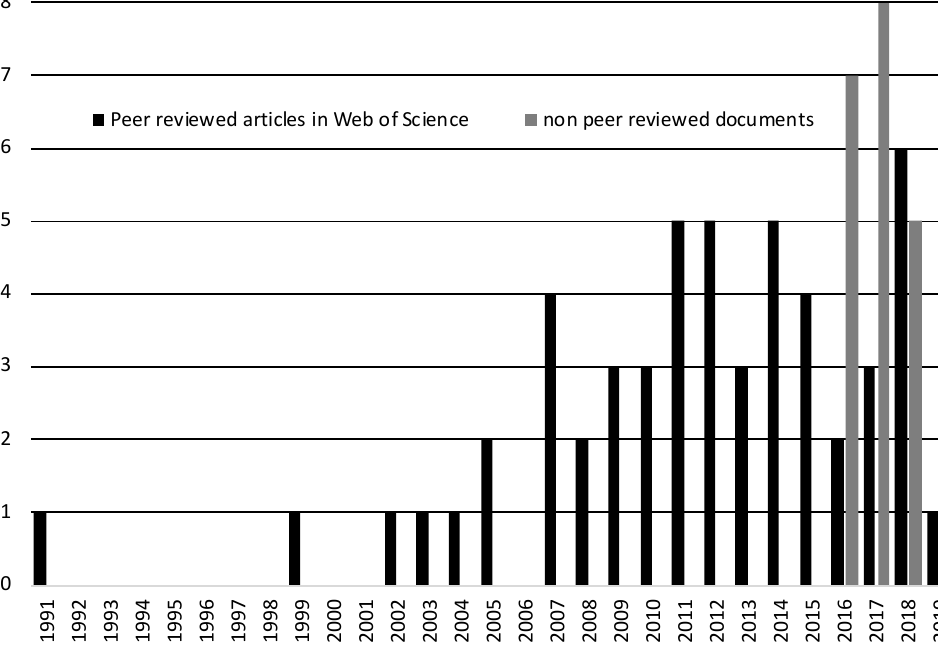
Figure 3. Temporal distribution of publications reviewed